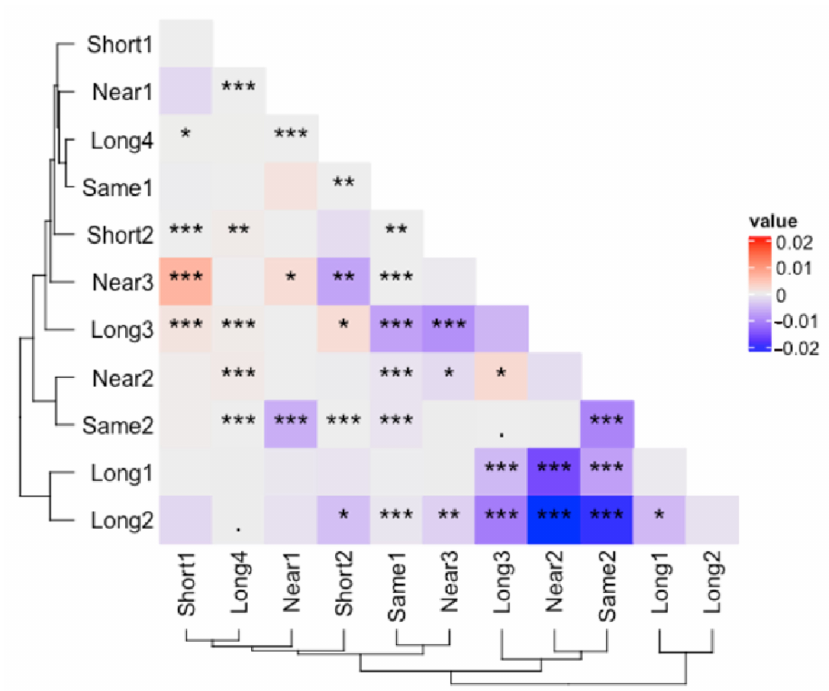
Figure 5. The average effectiveness of the correction in overall level ( E ) for community structure similarity improvement. The color scheme distinguishes between increased (blue) and decreased (red) similarity resulting from the correction. Statistical significance is represented by asterisks, with *** indicating a p -value < 0.001, ** indicating a p -value < 0.01, * indicating a p -value < 0.05, and ‘.’ indicating a p -value <